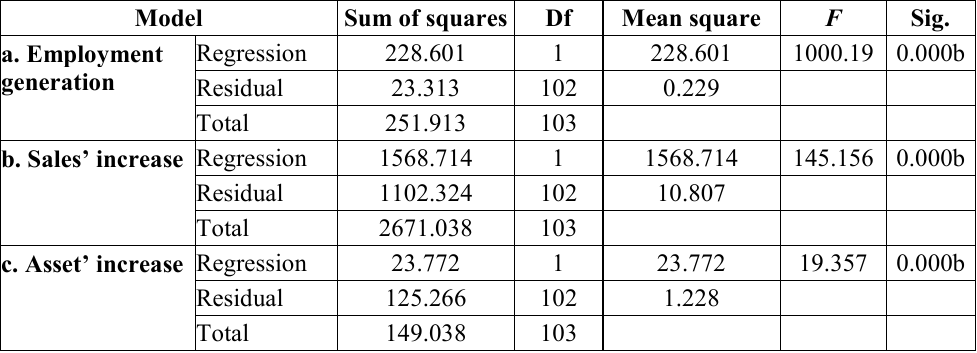
Table 6. ANOVA of the Relationship between Dependent and